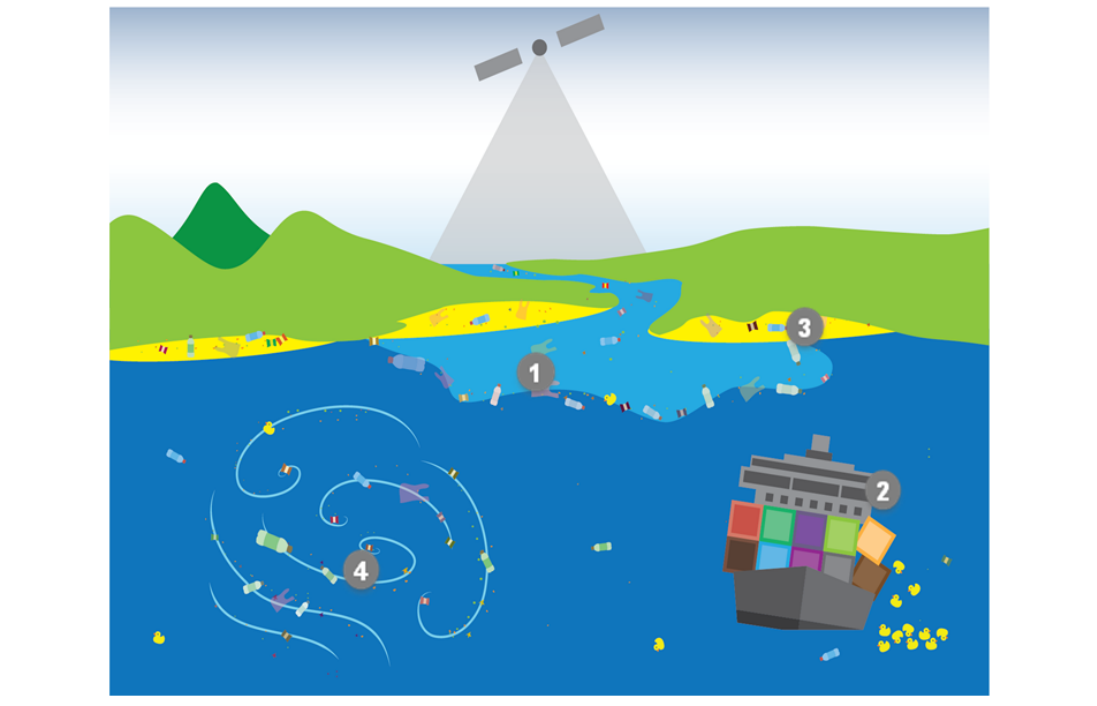
Figure 1. Diagram representing the four observational scenarios discussed in the text (Section